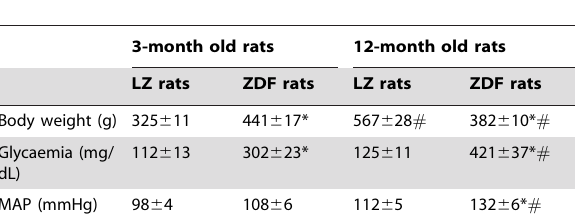
Table 1. Rat body weight, glycaemia and mean arterial blood pressure (MAP) were measured in 3- and 12-month old LZ and ZDF rats.